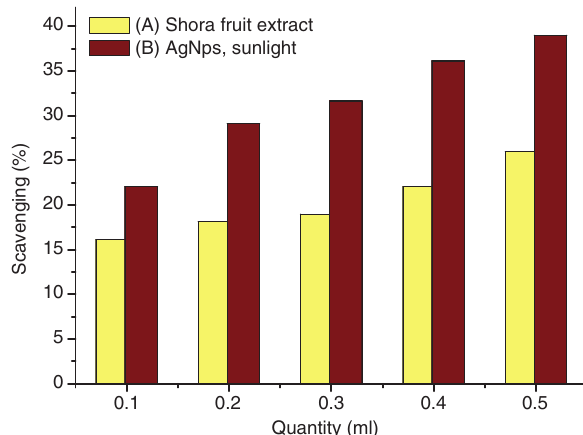
Figure 7: Scavenging activity of (A) Shora fruit extract and (B) silver nanoparticles